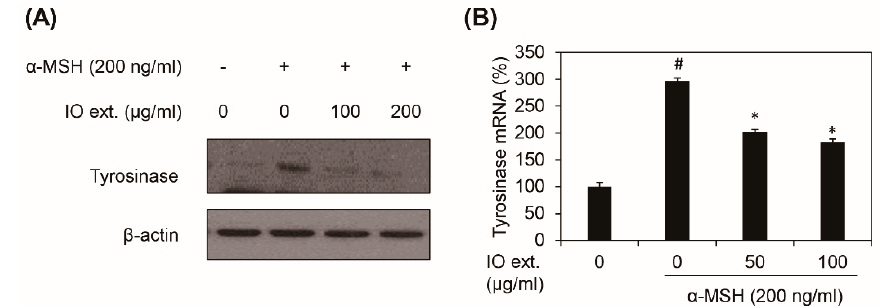
Figure 4. Effects of Inonotus obliquus extract on tyrosinase expression. The Inonotus obliquus extract decreased the tyrosinase expression in the B16F10 mouse melanoma cells. ( A ) The protein level of tyrosinase was identified by western blotting. β -Actin was used as the loading control; ( B ) The mRNA expression of tyrosinase was identified by qRT-PCR. The mRNA levels of tyrosinase were shown as a percentage of the control at the stated concentrations. All the data values were obtained from the average of three independent experiments ±SD (standard deviation). #: p < 0.05 compared with the non-treated B16F10 cells; *: p < 0.05 compared with the α -MSH-treated B16F10 cells; IO ext.: Inonotus obliquus extract extracts; and α -MSH: alpha-melanocyte-stimulating hormone.